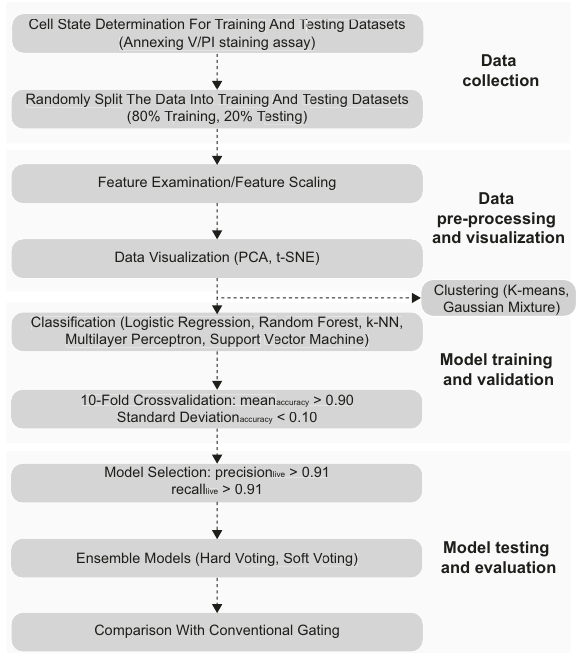
Fig. 2 General work fl ow of building a cell morphology-based machine learning model. The modeling process consists of four steps: Data collection, Data pre-processing and visualization, Model training and validation, and Model testing and